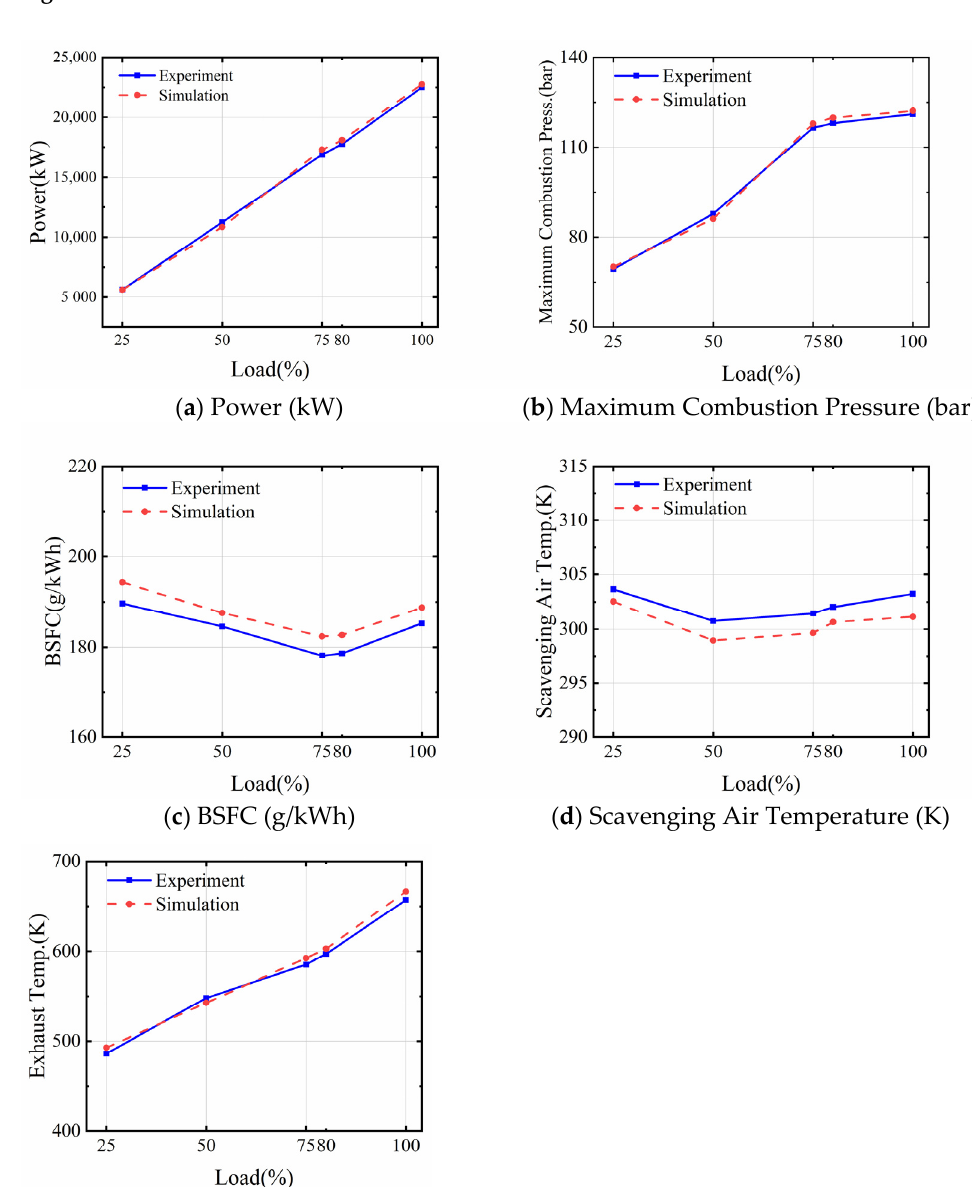
Figure 4. Comparison of simulation and experiment in diesel mode.